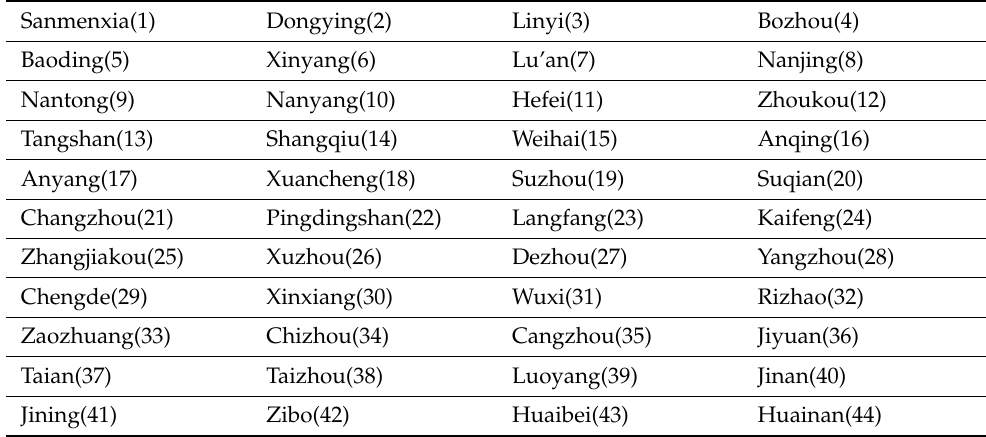
Table A1. All cities and their code